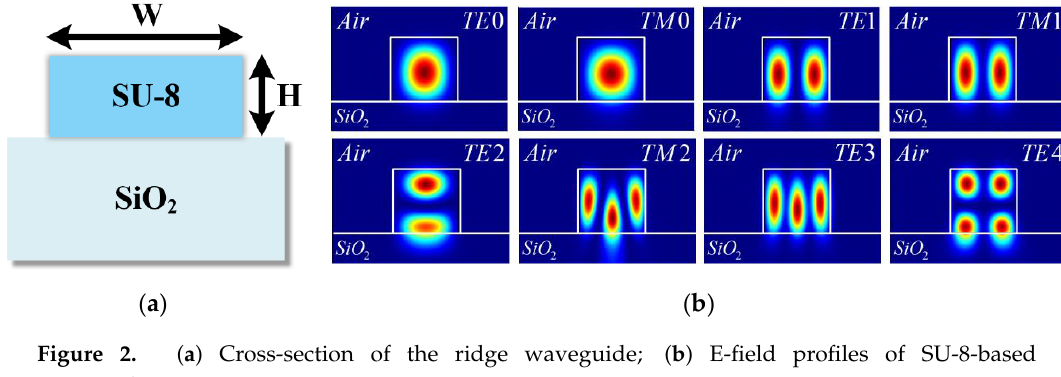
Figure 2. ( a ) Cross-section of the ridge waveguide; ( b ) E-field profiles of SU-8-based waveguide structure.